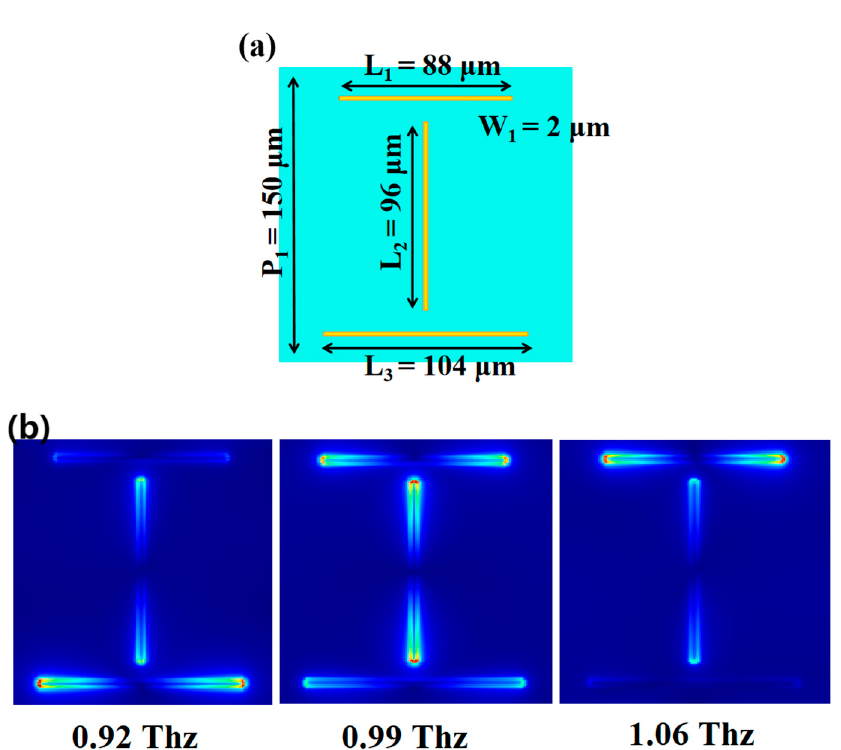
Figure 2. ( a ) Schematic diagram of the quarter-wave plate, where P 1 represents the length of one unit cell, L 1 , L 2 , and L 3 represent the length of the Cu wire, and W 1 represents the width of the Cu wire. ( b ) The electric field of one unit cell on the metasurface at 0.92 Thz, 0.99 Thz, and 1.06 Thz. Here, ∆ ϕ corresponds to the phase difference ( ∆ ϕ = ϕ y − ϕ x ). The ellipticity is defined as χ = S 3 / S 0 . χ = − 1 indicates a right circular polarization. χ = 1 indicates left circular polarization. Ellipticity can evaluate the performance of the quarter wave plate. Figure 3 shows the phase delay (a) and ellipticity (b). The x electric field component produces two phase delays. They are excited by L 1 and L 3 parallel to the X -axis. The y electric field component produces one phase delay. It is excited by L 2 parallel to the y -axis. L 1 and L